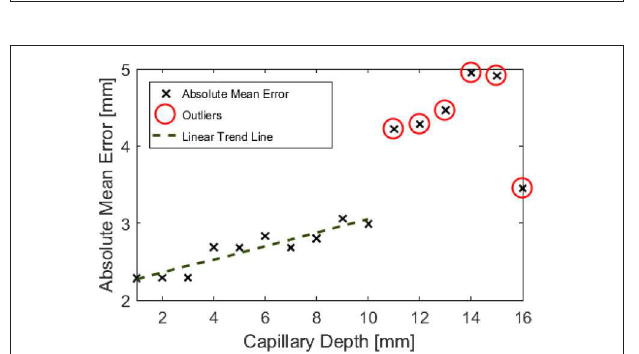
FIGURE 9 | Absolute mean error in depth estimation of the entire field of view against controlled submersion depth.